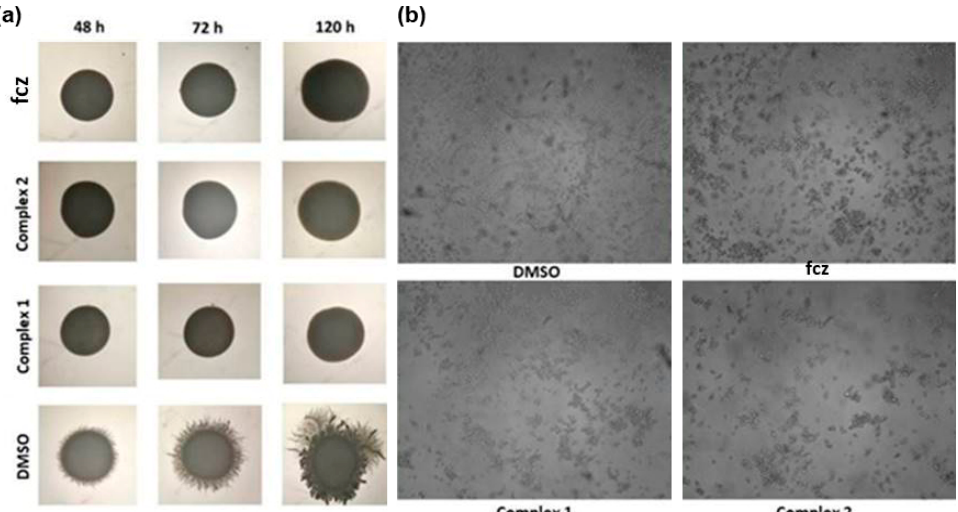
Figure 4. Filamentation of C. albicans ATCC 10231 in the presence of subinhibitory (0.5 × MIC value) concentrations of Figure 1. and 2 on the solid Spider medium ( a ) and in RPMI broth ( b ) (Olympus BX51, Applied Imaging Corp., San Jose, CA, United States, under 20× magnification).